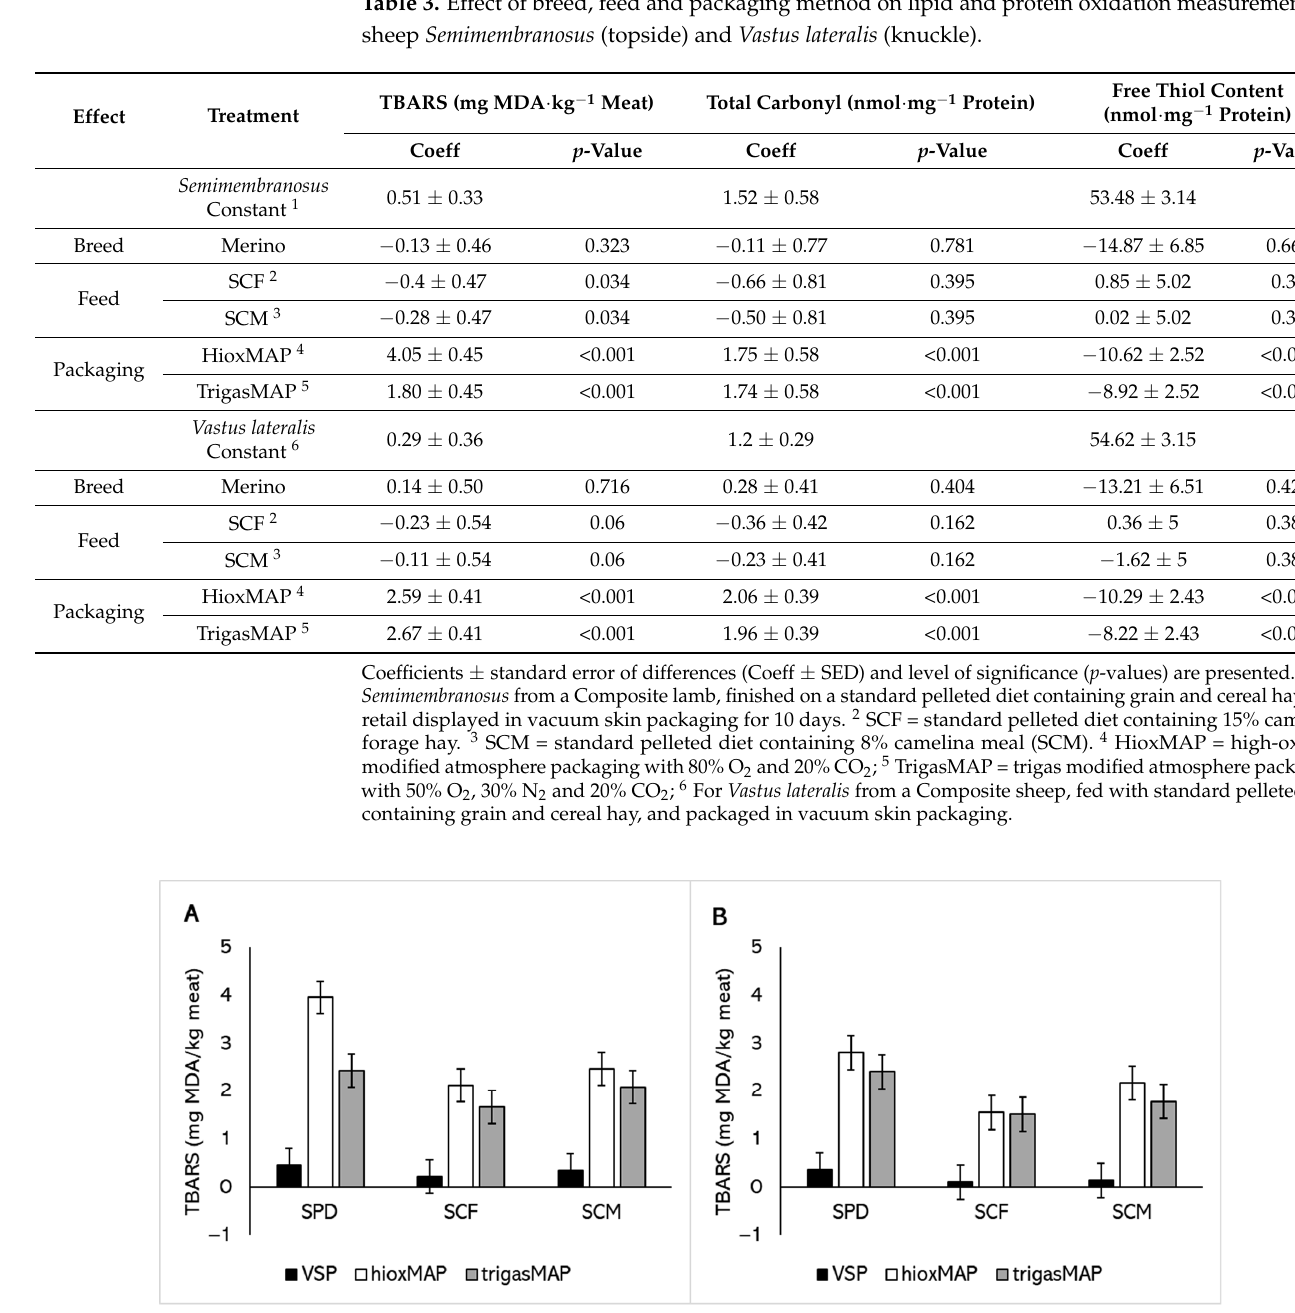
Figure 4. Thiobarbituric acid reactive substances (TBARS) values of ( A ) Semimembranosus and ( B ) Vastus lateralis from sheep finished on three diets (SPD = standard pelleted diet containing grain and cereal hay; SCF = pelleted mixture diet containing 15% camelina forage hay; or SCM = pelleted mixture diet containing 8% camelina meal) and retail displayed in three packaging methods (VSP = vacuum skin packaging; HioxMAP = high-oxygen modified atmosphere packaging with 80% O 2 and 20% CO 2 ; or TrigasMAP = trigas modified atmosphere packaging with 50% O 2 , 30% N 2 and 20% CO 2 ). Values are predicted means ± standard error of differences (SED). p (feed × packaging method) values are 0.011 for Semimembranosus ( A ) and 0.243 for Vastus lateralis ( B ).